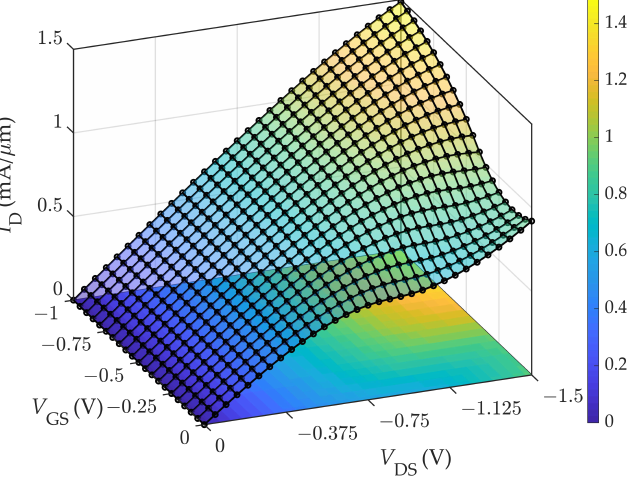
Figure 2. Surface plot of the drain current I D computed by varying the V GS and V DS .